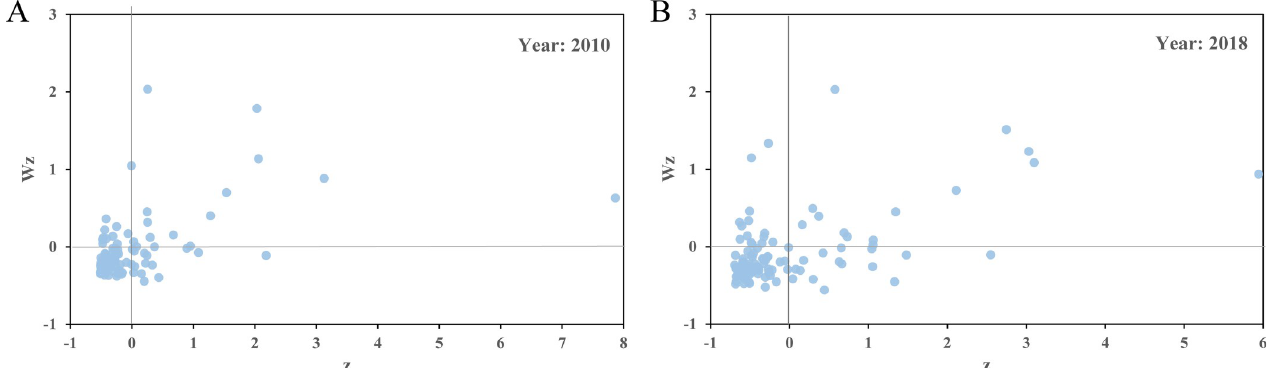
Fig 9. Moran scatter plot of total carbon emissions from civil buildings in Chinese cities in 2000 (A) and 2018 (B).